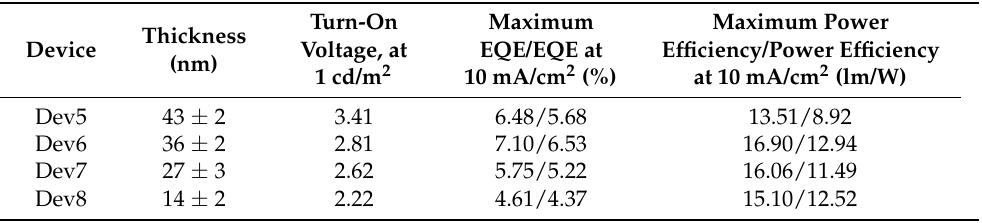
Table 4. Properties of OLED devices for device structure: ITO, PEDOT:PSS (40 nm), TAPC:PO-T2T (2:1) with different thicknesses, POT2T (60 nm), LiF (1 nm), and Al (100 nm).